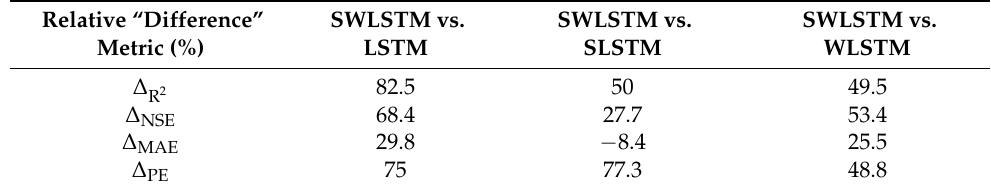
Table 7. Accuracy improvements of SWLSTM to three other models of LSTM, SLSTM, and WLSTM for dam inflow predictions for the test dataset. A relative “difference” metric ( ∆ Metric ) in Equation (20) is computed for four evaluation metrics (R2, NSE, MAE, and PE). The positive (or negative) values of ∆ Metric indicate that the prediction results of SWLSTM are more (or less) accurate than those computed by other models. The optimal hyper-parameters specified in Table 6 and the 5-folds ( K = 5) are employed. SWLSTM